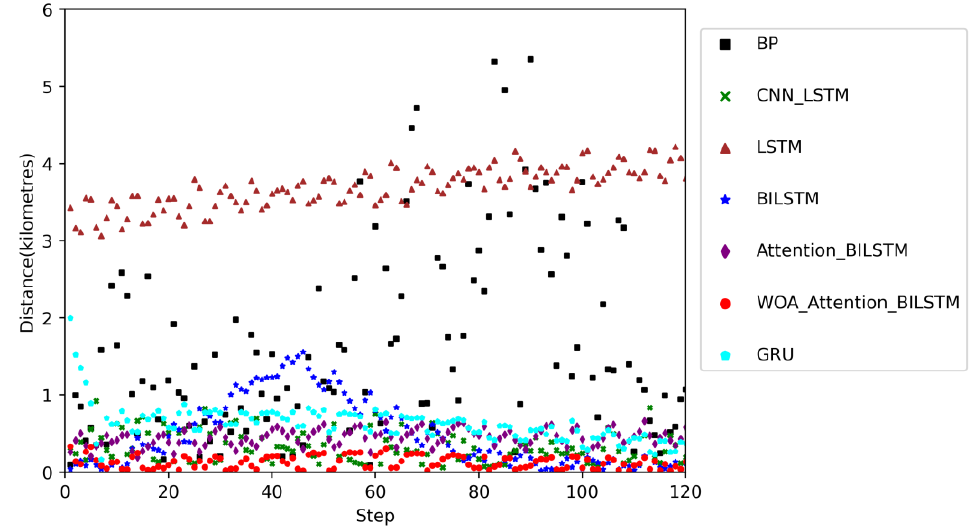
Figure 13. Comparison of model prediction results by Haversine Distance.